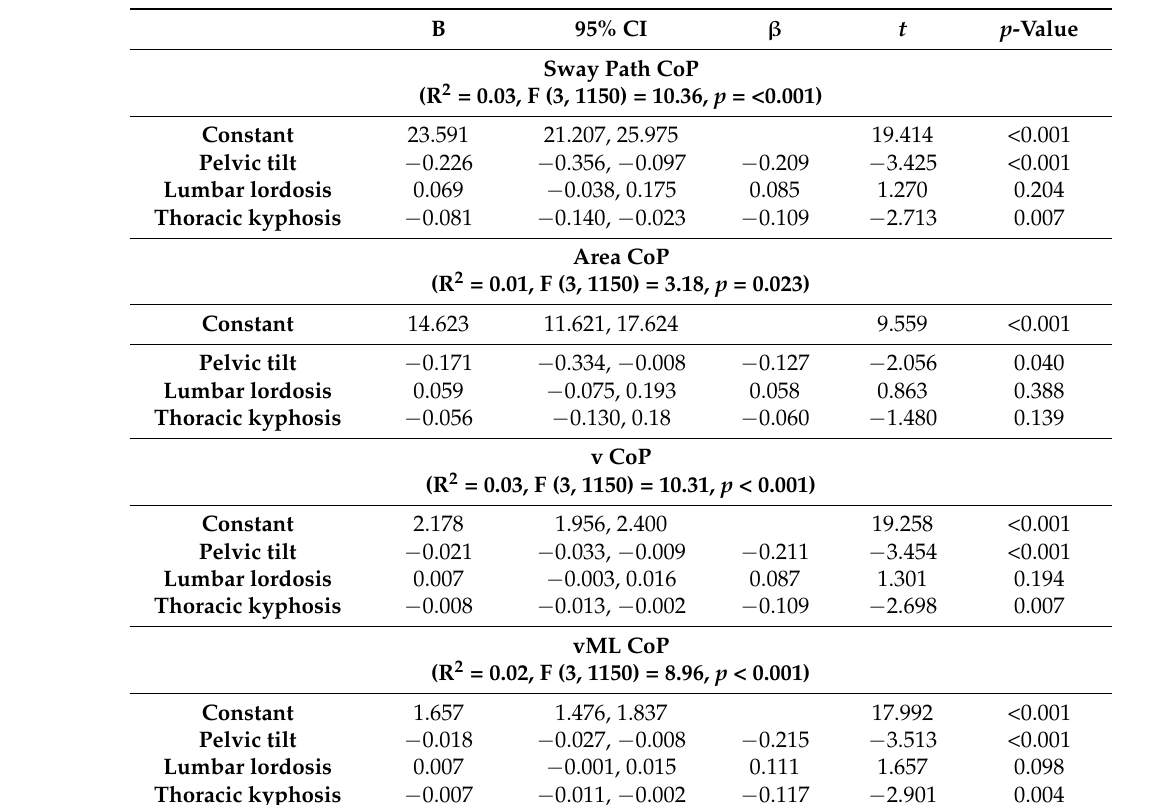
Table 4. Multiple linear regression between the angles of sagittal spinal posture and the stabilometric